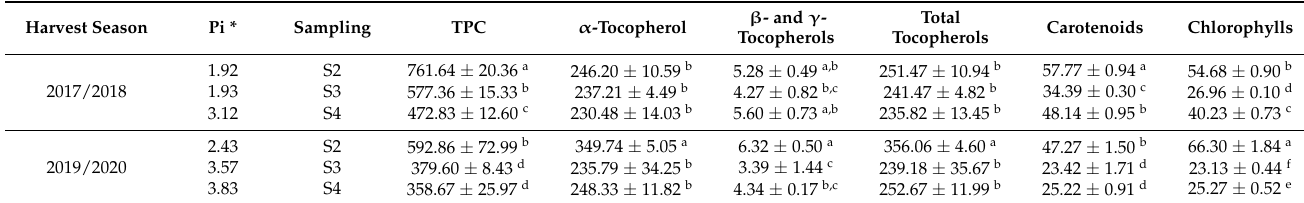
Table 3. Minor compounds (mg kg − 1 ) of the Oliva Rossa VOOs extracted during fruit ripening in two different harvest seasons (mean ± SD, n =